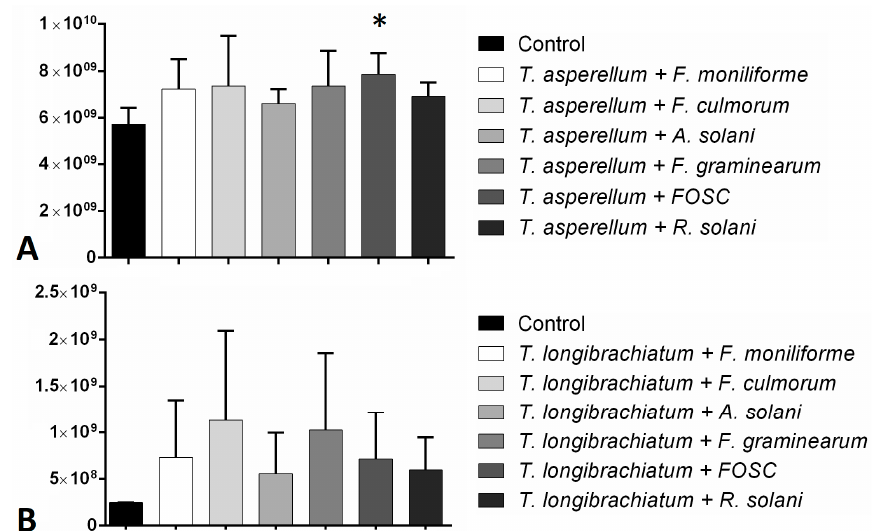
Figure 5. Total amounts of peptaibols produced by Trichoderma asperellum IRAN 3062C ( A ) and T. longibrachiatum IRAN 3067C ( B ) in interaction with plant pathogenic fungi ( Fusarium moniliforme , F. culmorum , F. graminearum , FOSC, Alternaria solani , Rhizoctonia solani ) compared with the control